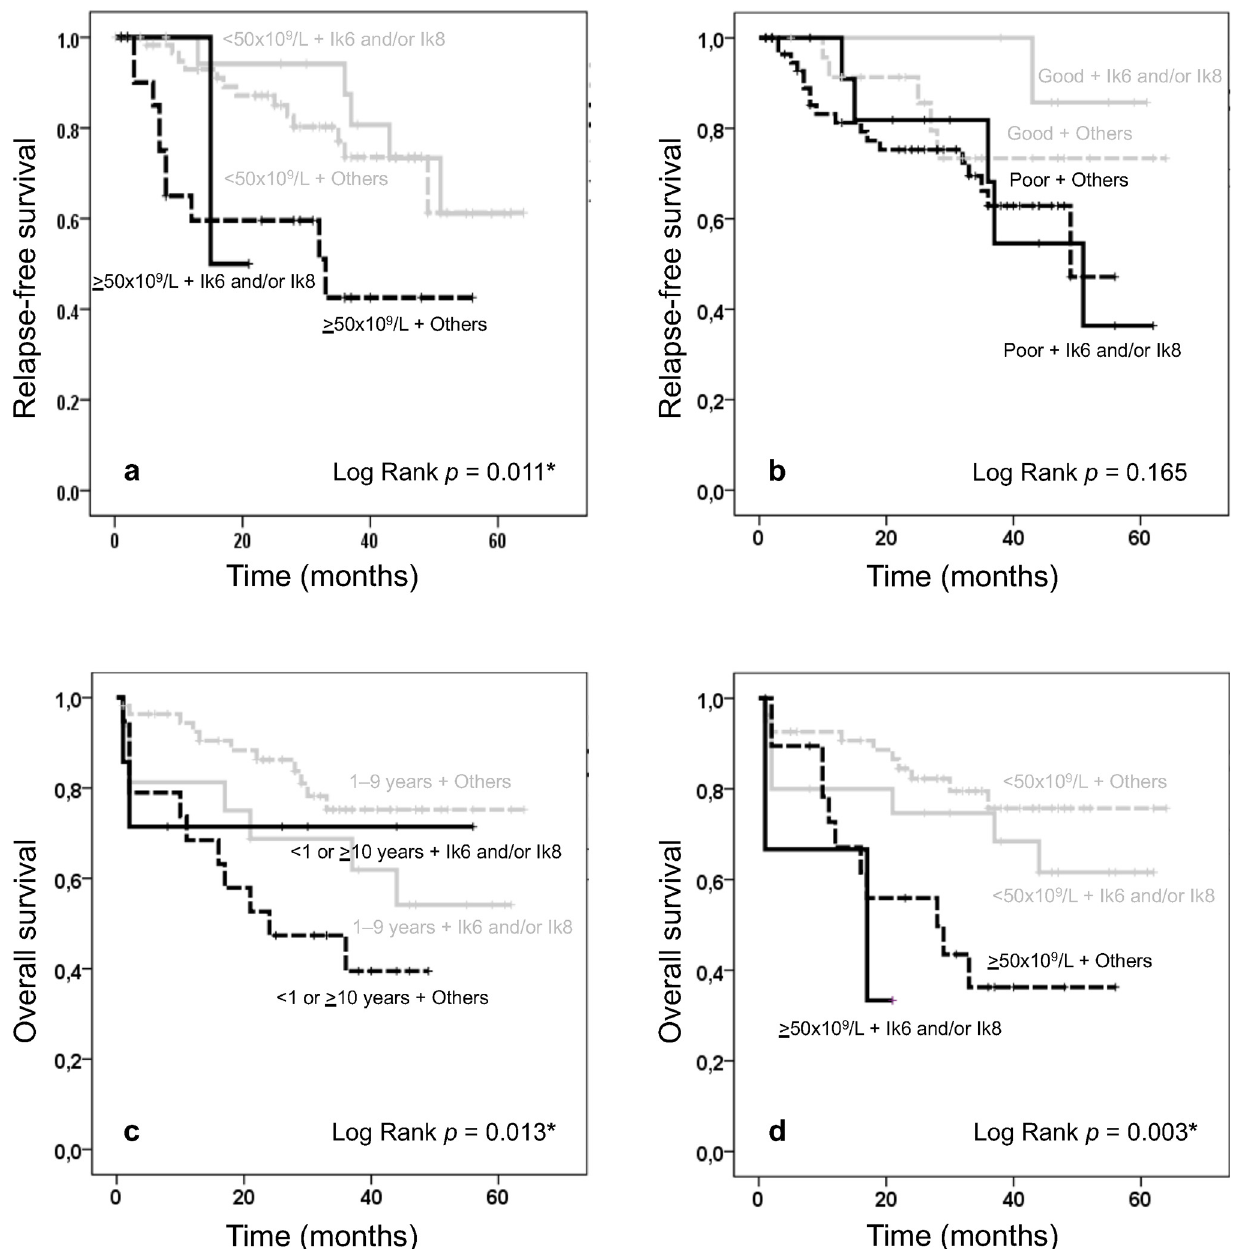
Fig 1. Kaplan Meier curves according to clinical risk. The clinical risk features as WBC count (a & d), prednisone response (b) and age (c) were evaluated according to the expression of Ik6 and/or Ik8 (solid gray and black line) or other Ikaros isoforms (dotted gray and black lines). We observed statistical difference for age and WBC